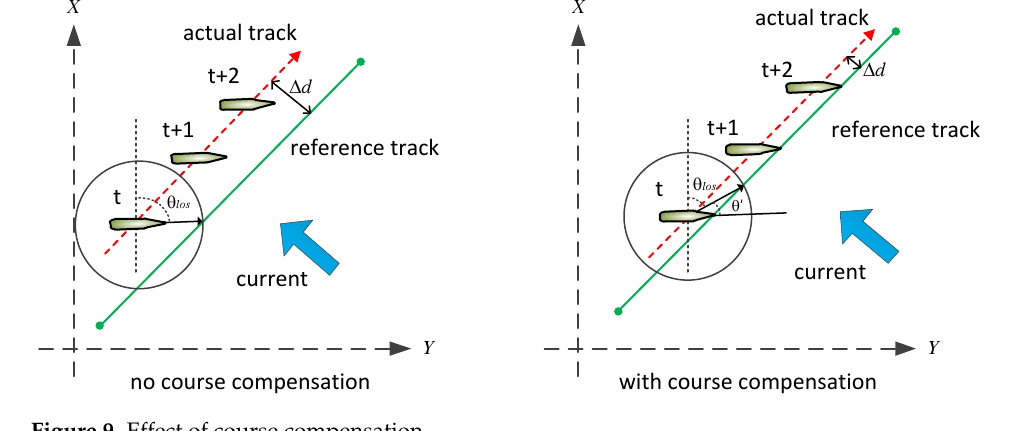
Figure 9. Effect of course